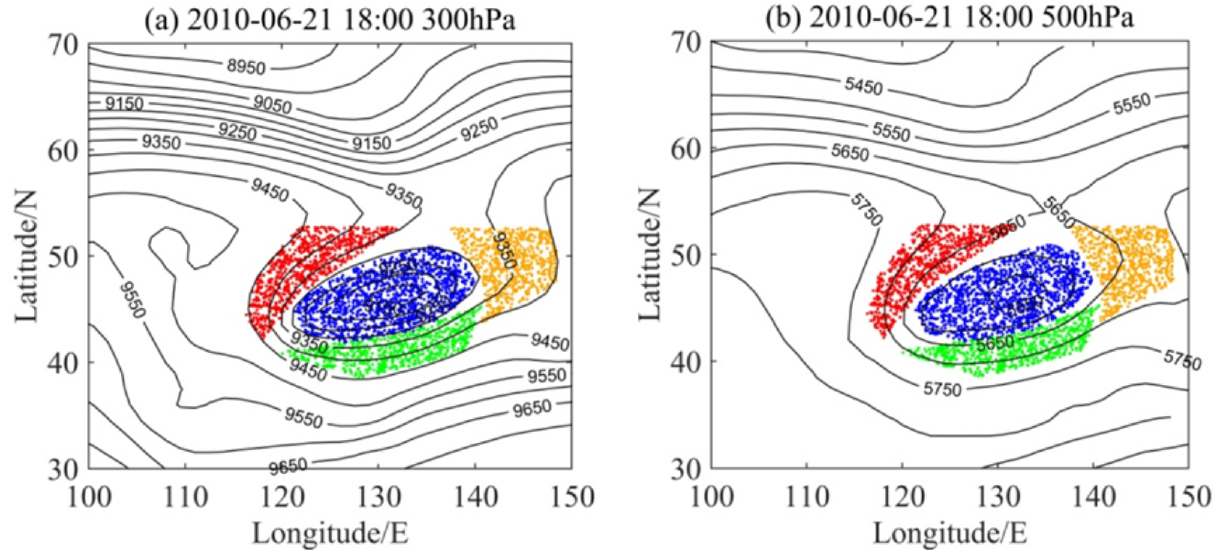
Figure 4. Schematic diagram of the partition of target air parcels lying in the center (blue), east (orange), west (red), and south (green) side of the COL at 300 hPa ( a ) and 500 hPa ( b